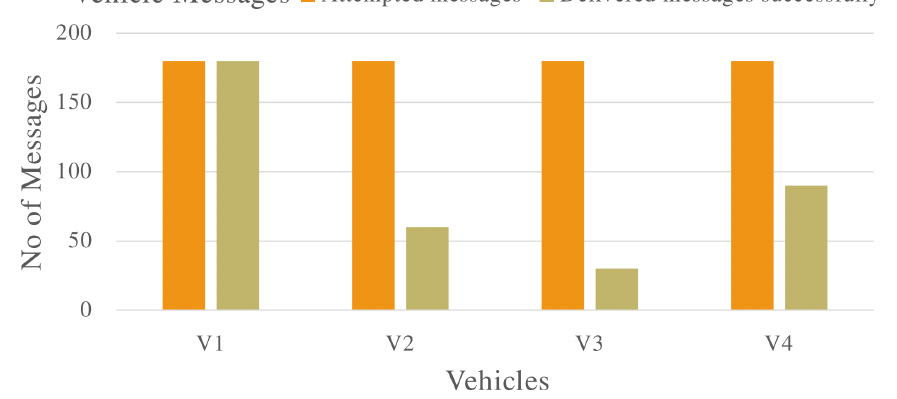
Figure 3. Total messages transmitted by vehicles in the VANET populated with malicious vehicles that are dropping